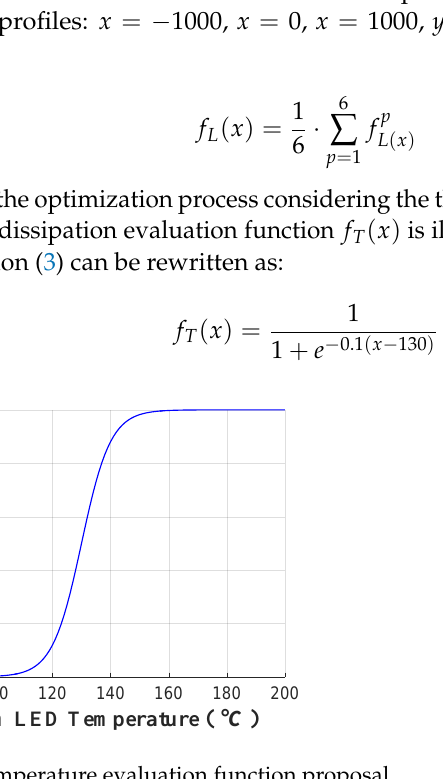
Figure 13. New temperature evaluation function